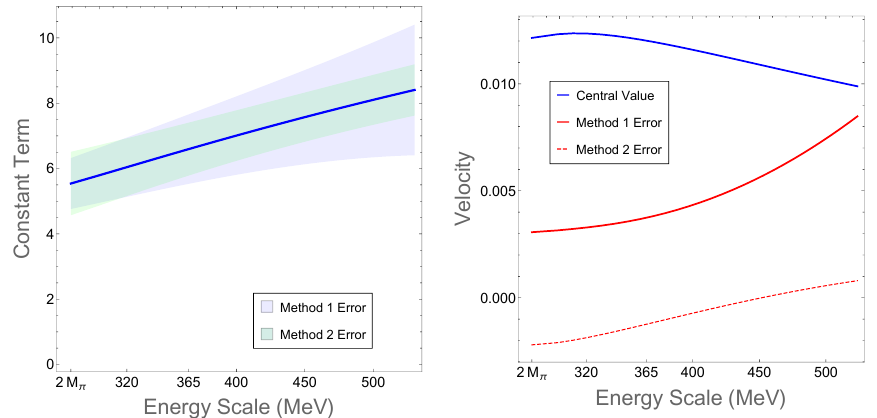
Figure 9 . Error estimates of the improved (cid:22) l 1 and (cid:22) l 2 bounds for di(cid:11)erent (cid:15) (cid:3) subtractions (\Energy Scale" denotes the value of (cid:15) (cid:3) M (cid:25) ). The left sub(cid:12)gure shows the error estimates of the (cid:22) l 2 + 2(cid:22) l 2 bounds (\Constant Term" denotes the right hand side of (cid:22) l 2 + 2(cid:22) l 2 > Constant Term, which depends on the (cid:15) (cid:3) subtraction). The blue solid line is the O ( p 4 ) value of the Constant Term, and the error is estimated with the value of the Constant Term at O ( p 6 ). Two error estimation methods are represented: Method 1 (light blue region) is to only compute the two loop contribution at O ( p 6 ) and multiply it by a factor of 3, which is to roughly account for the badly known tree and one loop contributions at O ( p 6 ); Method 2 (light green region) is to set all the b i constants to the central values of their estimates provided by Colangelo et al. [71] at O ( p 6 ) (see eq. (4.12)). The right sub(cid:12)gure shows the growth rate of the O ( p 4 ) value of the Constant Term (blue line, \Central Value") and the error estimates (red solid line for Method 1 and red dashed line for Method 2) for the left sub(cid:12)gure. We see that for (cid:15) (cid:3) below 490MeV the improvement of the bounds outruns the increase of the error estimates.